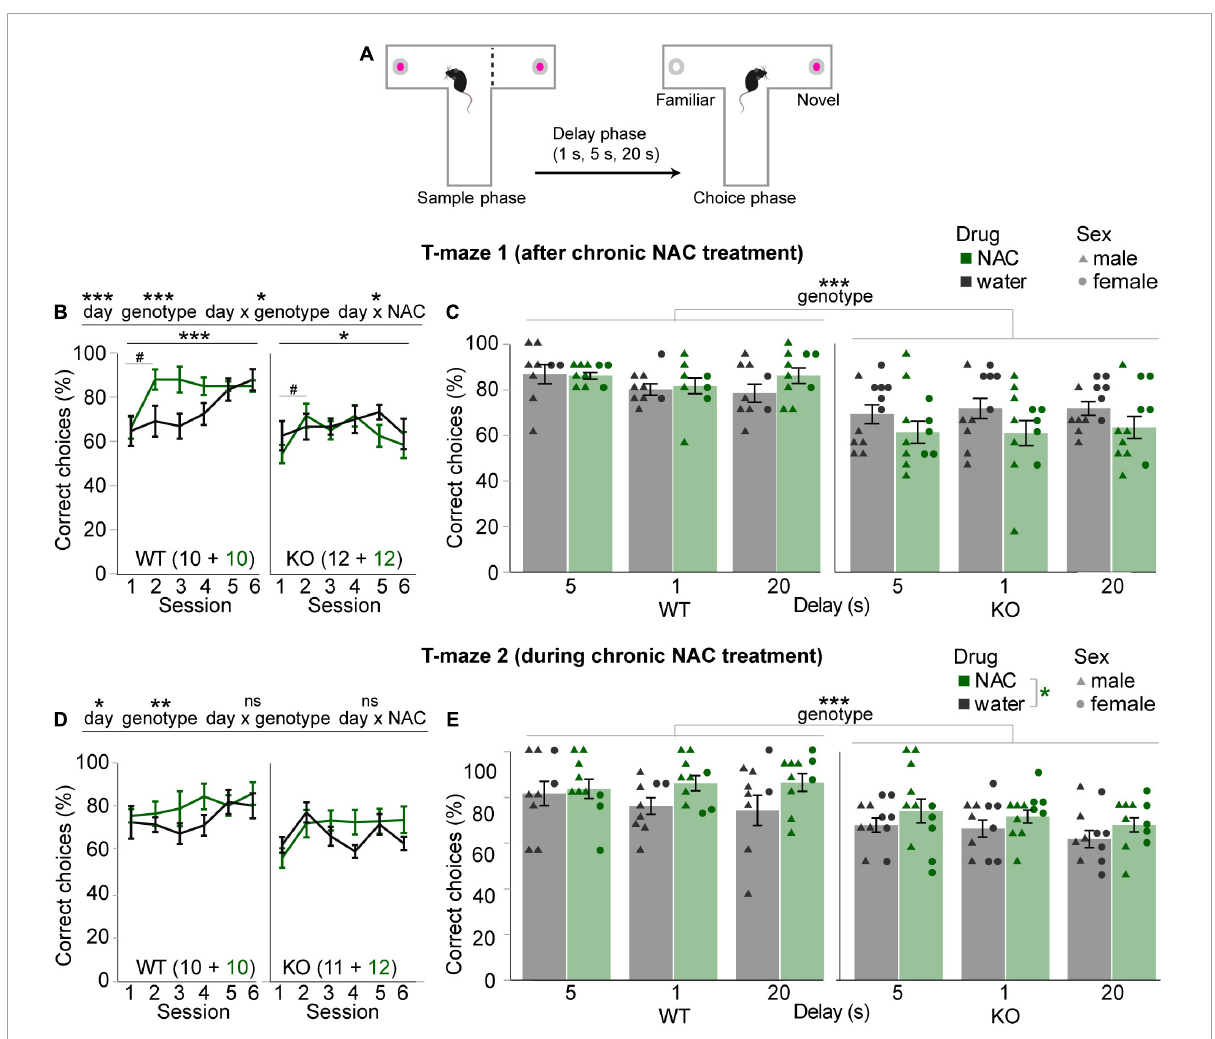
FIGURE2 Mild improvement of spatial working memory by concomitant chronic N-acetylcysteine treatment. (A) Design of the T-maze rewarded alternation task. (B,D) Average SWM accuracy (%correct choices) in the first six training sessions (all run with a 5 s delay) of the first (B) and second (D) T-maze experiments shown for NAC-treated (green) and untreated (black) mice of the genotype indicated in the bottom left of each subpanel, also displaying n-numbers. Main effects and interactions from overall RM-ANOVA are indicated above panels; main effect of day for RM-ANOVA within each subgroup indicated underneath where significant; pairwise Šidák post-hoc tests were conducted between consecutive sessions within subgroups due to significant day-genotype and day-NAC interactions in panel (B) and indicated trends of improvement in NAC-subgroups (#) between the first two sessions. (C,E) Data from the same experiments as displayed in neighboring panels (B,D) with the same color code, but showing averages between the two last sessions with the same delay (stated on x -axes) and data of individual animals, coded by treatment and sex. Main effects of overall RM-ANOVA across delays and subgroups are indicated, if significant, above panels (genotype; C,E ) and in the legend (NAC-treatment; E ). No significant interactions were found. # p < 0.1; * p < 0.05; ** p < 0.01; *** p < 0.001. Error bars,